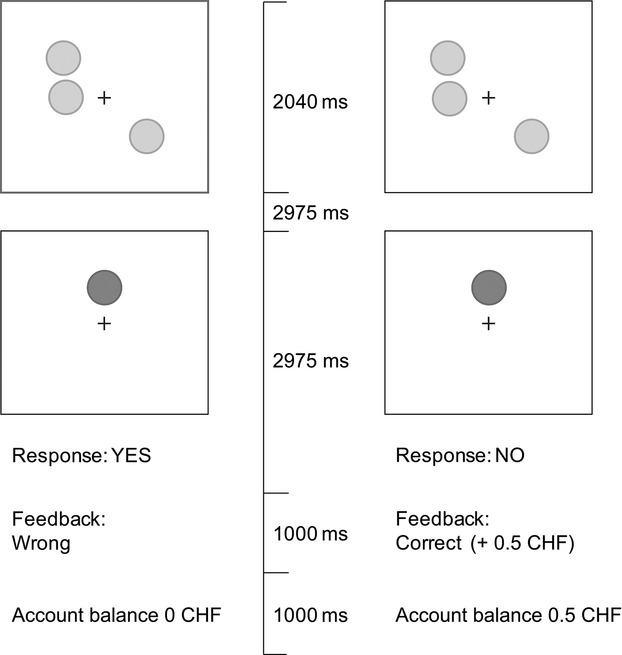
Illustration of a rewarded trial of the spatial delayed recall task at the easiest level of difficulty. In the first display, an array of yellow circles (3, 5 or 7) is presented for 2000 ms after a fixation time of 500 ms. After a delay of 3000 ms, a green circle appears and the subject has 3000 ms to decide whether the position of the green circle is the same as one of the preceding yellow circles by pressing two different buttons. After the subject has responded or the response time has elapsed, the circle disappears and the feedback and accumulated amount of earned money appears on the screen (in the rewarded condition) or the screen remains blank (in the unrewarded condition). During the rewarded condition, participants can earn a monetary reward for every correct response. The monetary reward increased according to the difficulty of the task. During the nonreinforced condition, participants eceive no feedback on their answer. The positions of the circles varied randomly and were organized according to a 5 × 5 grid dividing the space into 25 possible positions.